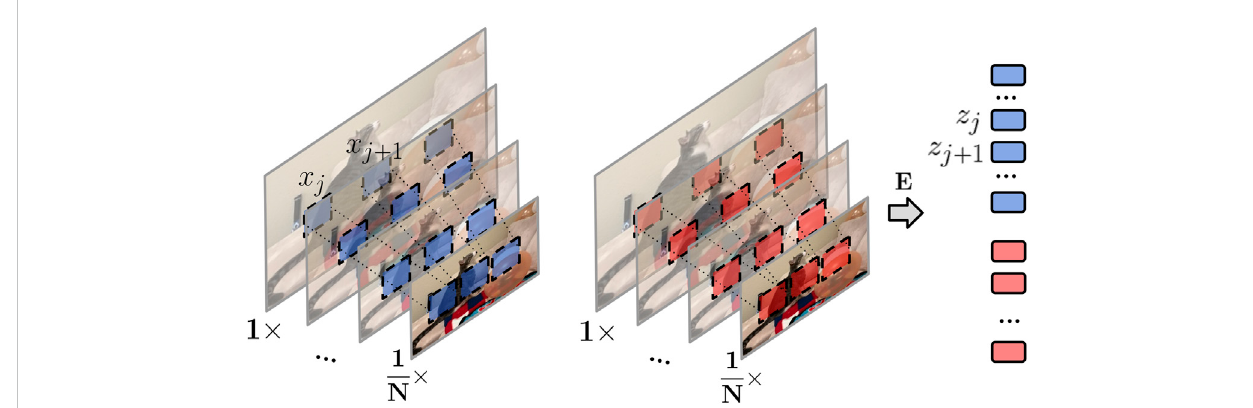
FIGURE 5 Multi-resolutionvideoframesembedding.Weextractcenter-alignedmulti-resolutionpatches,andthenlinearlyprojectthespatiallyaligned “ tubes ” of patches to 1D